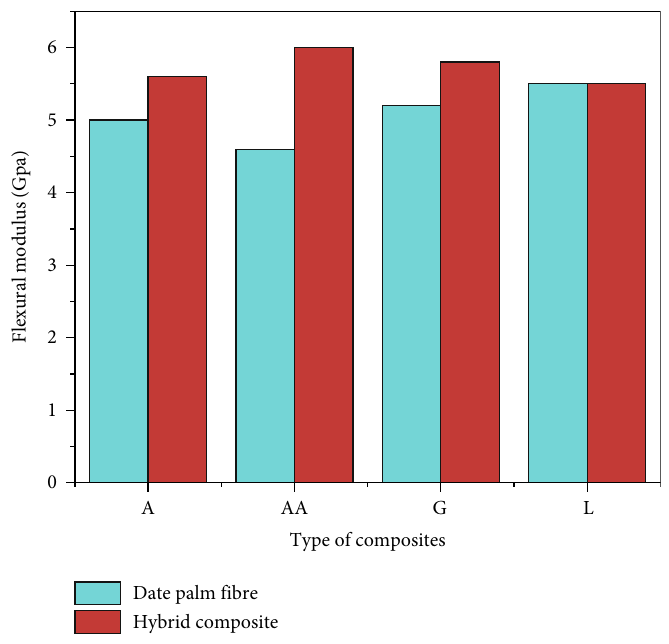
Figure 10: Flexural modulus of DPF and hybrid composite fi ber.